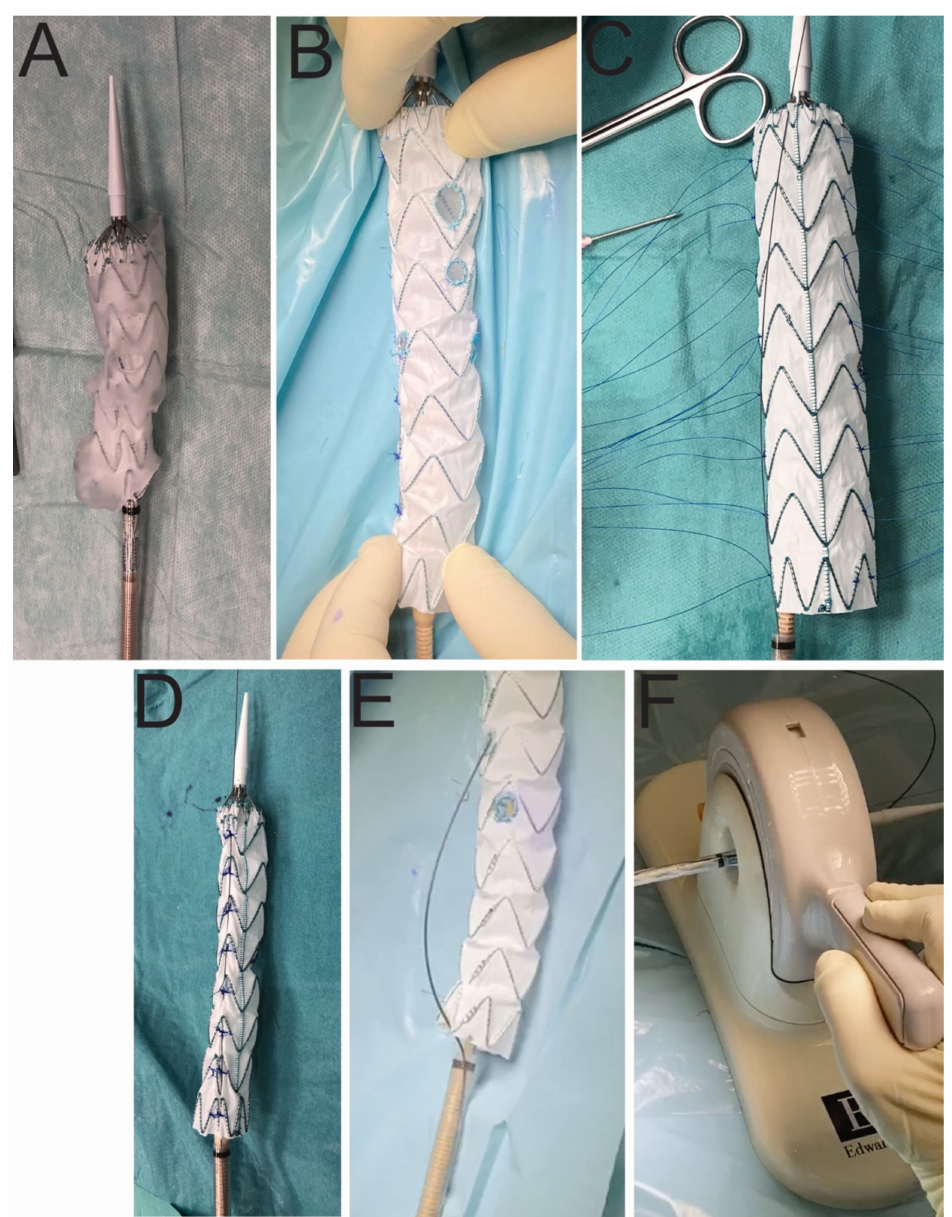
Figure 1. Stages of stent graft modification. Stent graft deployed in the 3D aortic template ( A ). Stent graft with created fenestrations ( B ). A step of reducing-tie creation ( C ). Reduced-diameter stent graft ( D ). A preloaded guidewire to the superior mesenteric artery ( E ). Stent graft resheathing using the aortic valve crimper ( F